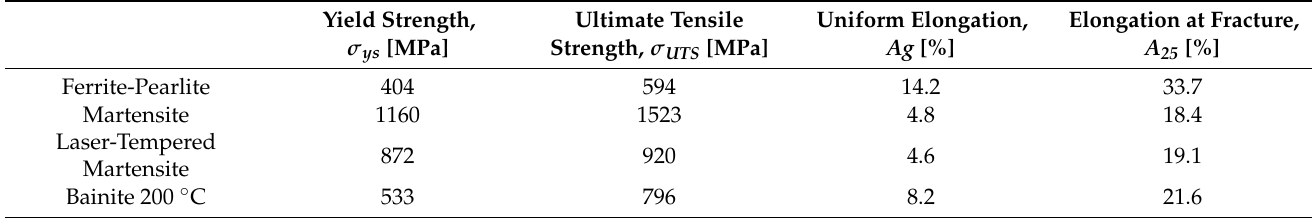
Figure 7. Engineering stress-strain curves for the studied press-hardened microstructures. Table 3. Tensile test results.